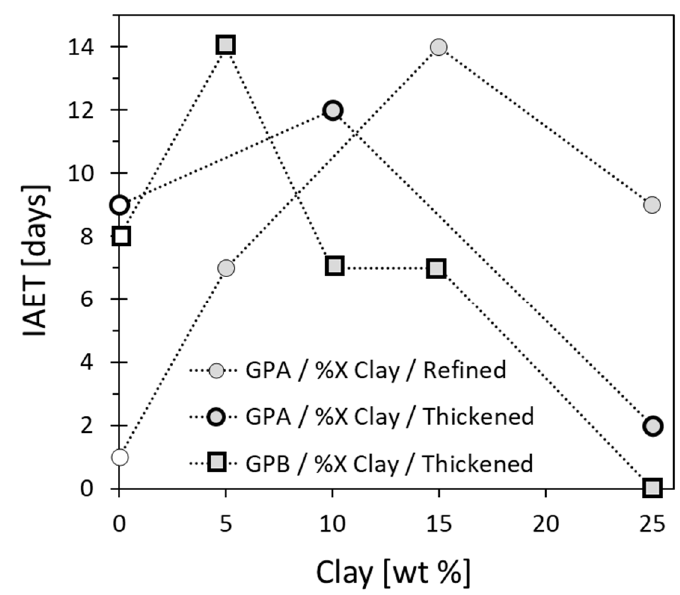
Figure 8. IAET as a function of clay loading at fixed graphite powder concentration of 25 wt%, for the two types of oil, refined and thickened, and for two types of graphite powder, GPA and GPB. All the IAETs are based on EC measurements (Figures S5–S7 in the Supplementary Materials) measured at 27 °C, atmospheric air (20% oxygen) and 40% RH. The dotted lines are drawn as guidance for the eye.